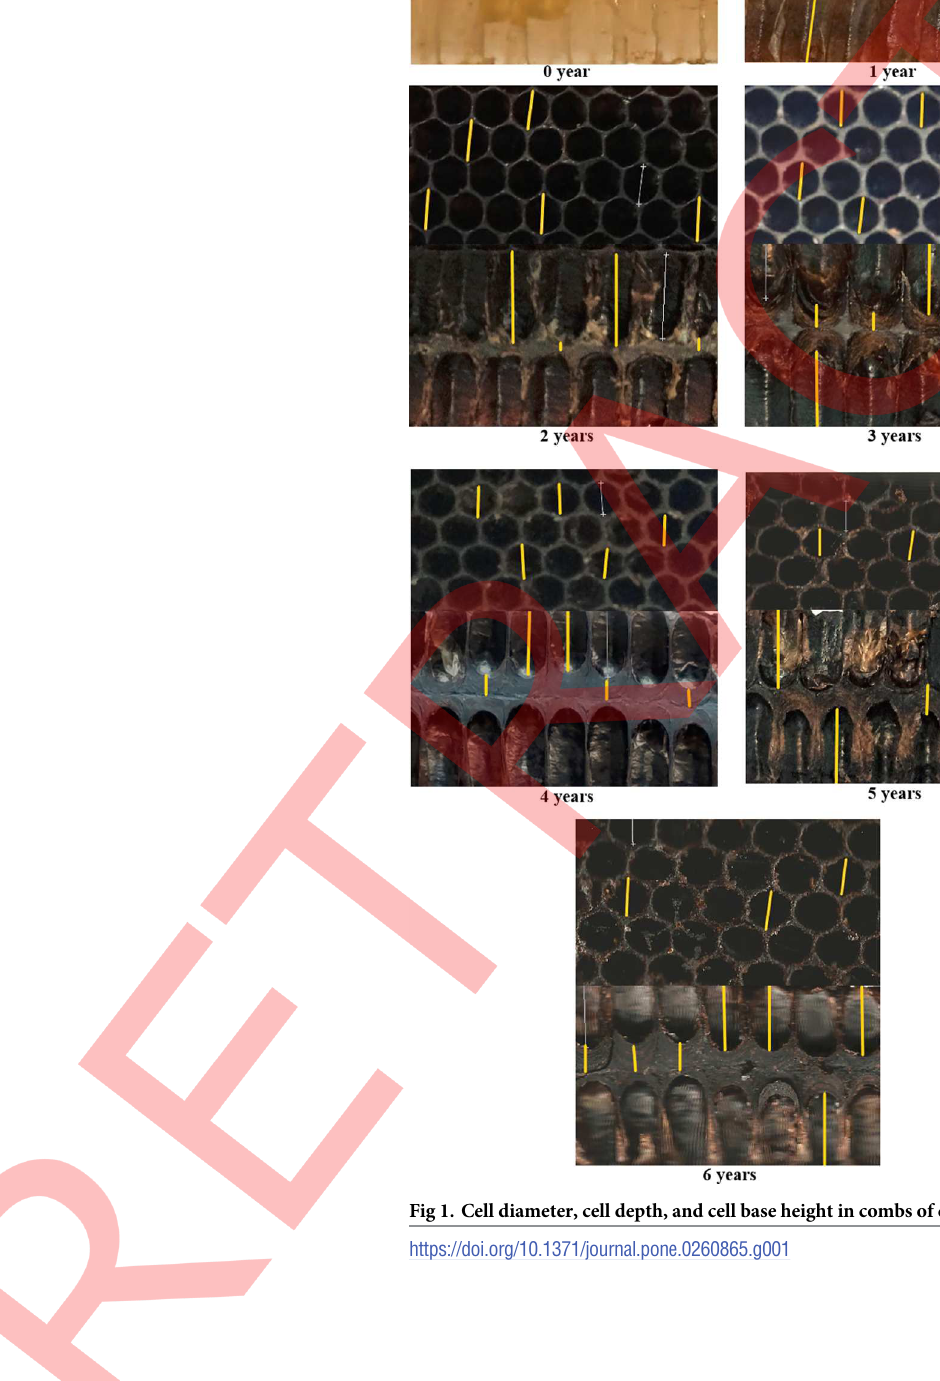
PLOS ONE | https://doi.org/10.1371/journal.pone.0260865 December3,